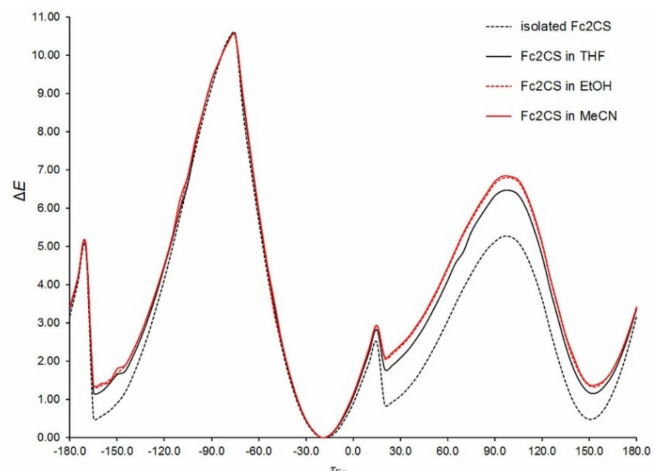
Figure 6. Energy of isolated and solvated Fc 2 CS molecules as a function of the dihedral angle describing the rotation of Fc-group ( τ Fc , in ◦ ). The energy ( ∆ E , in kcal mol − 1 ) is expressed relative to its lowest value in each